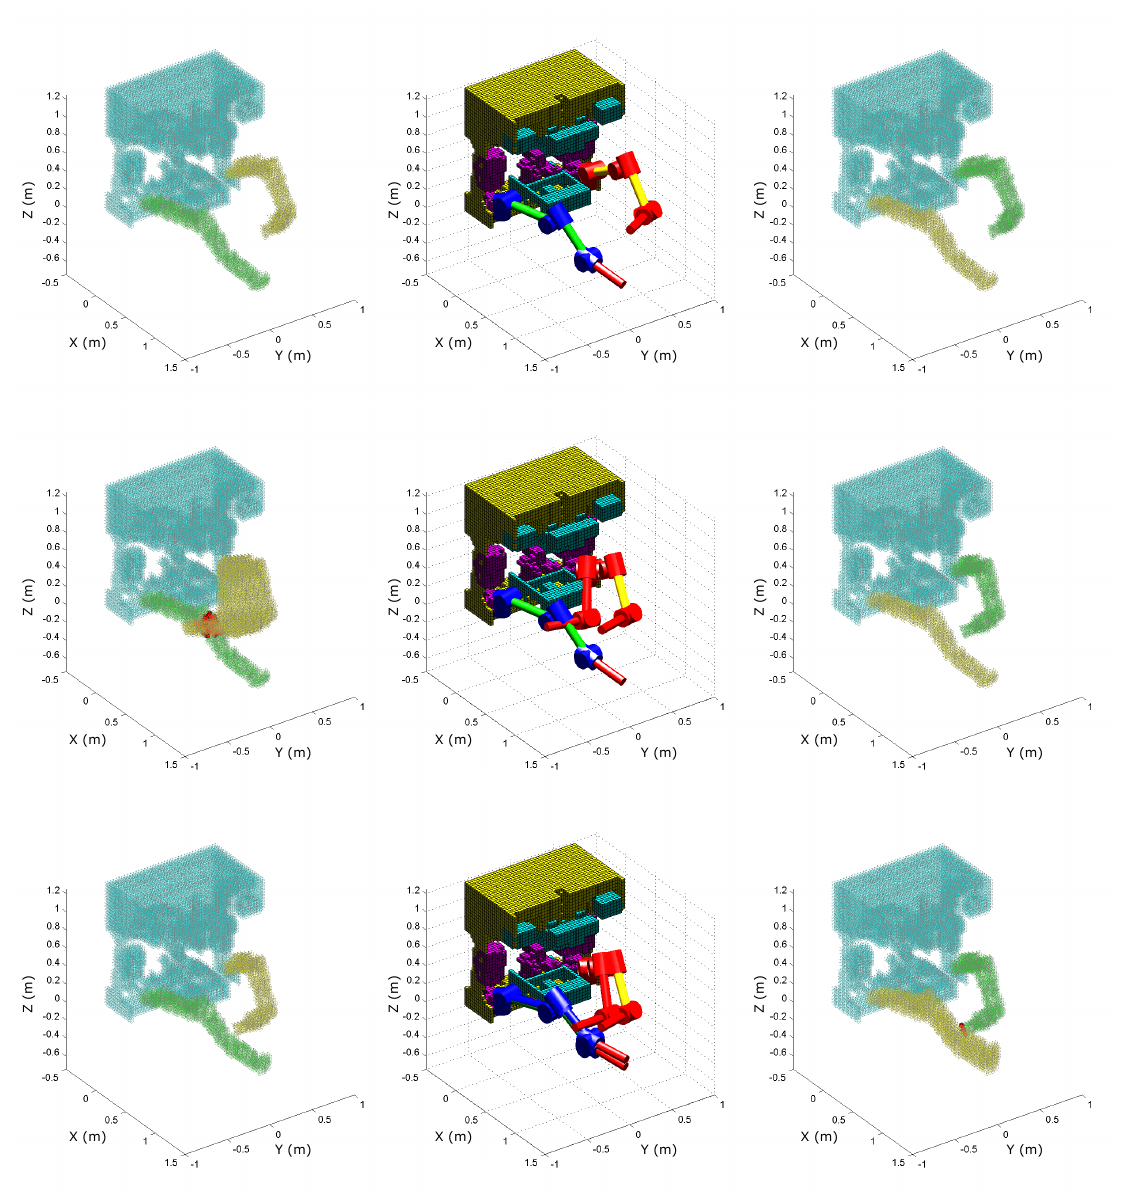
Figure 10. Simulation of the collision detection between two manipulators.